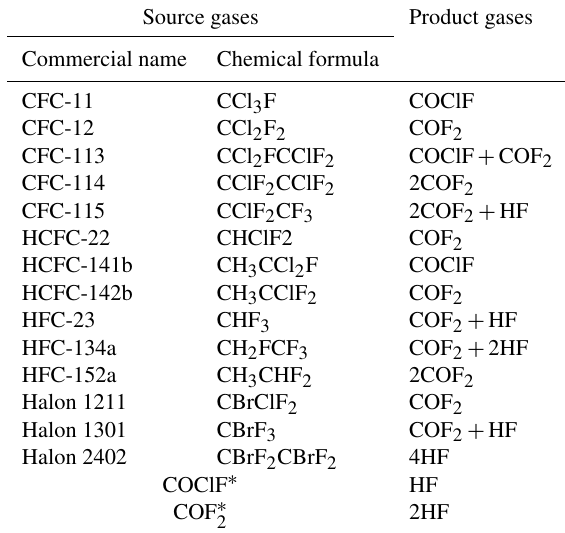
Table 4. Fluorine source gases in the SLIMCAT chemical scheme and their atmospheric degradation